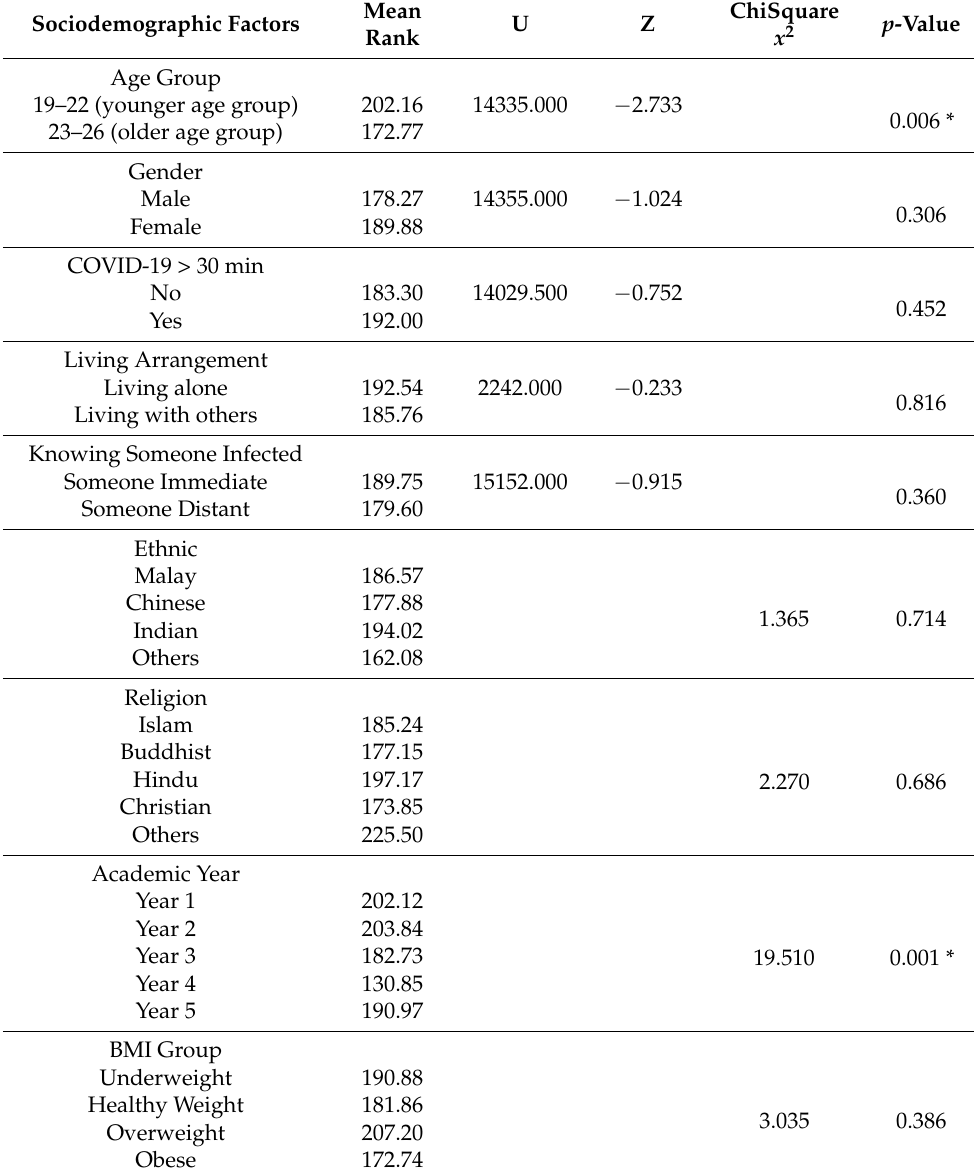
Table 3. Association between Sociodemographic Factors and Anxiety among Medical Students. Sociodemographic